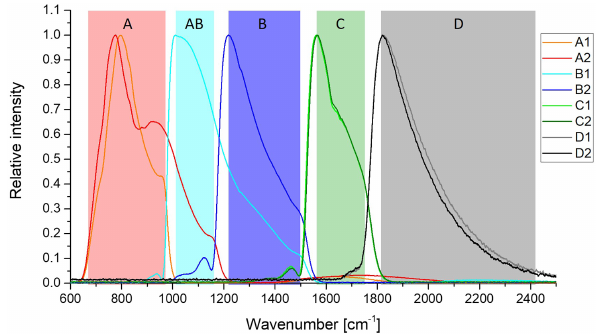
Figure 1. Spectral channels and resulting spectral bands of MIPAS. The curves show unfiltered spectra of blackbody measurements in relative units. The maximum of each channel is scaled to 1. Band A is composed of channels A1 and A2, AB of B1, B of B2, and C and D of C1 and C2 and D1 and D2, respectively. The colored boxes indicate the spectral coverage of the spectral bands.